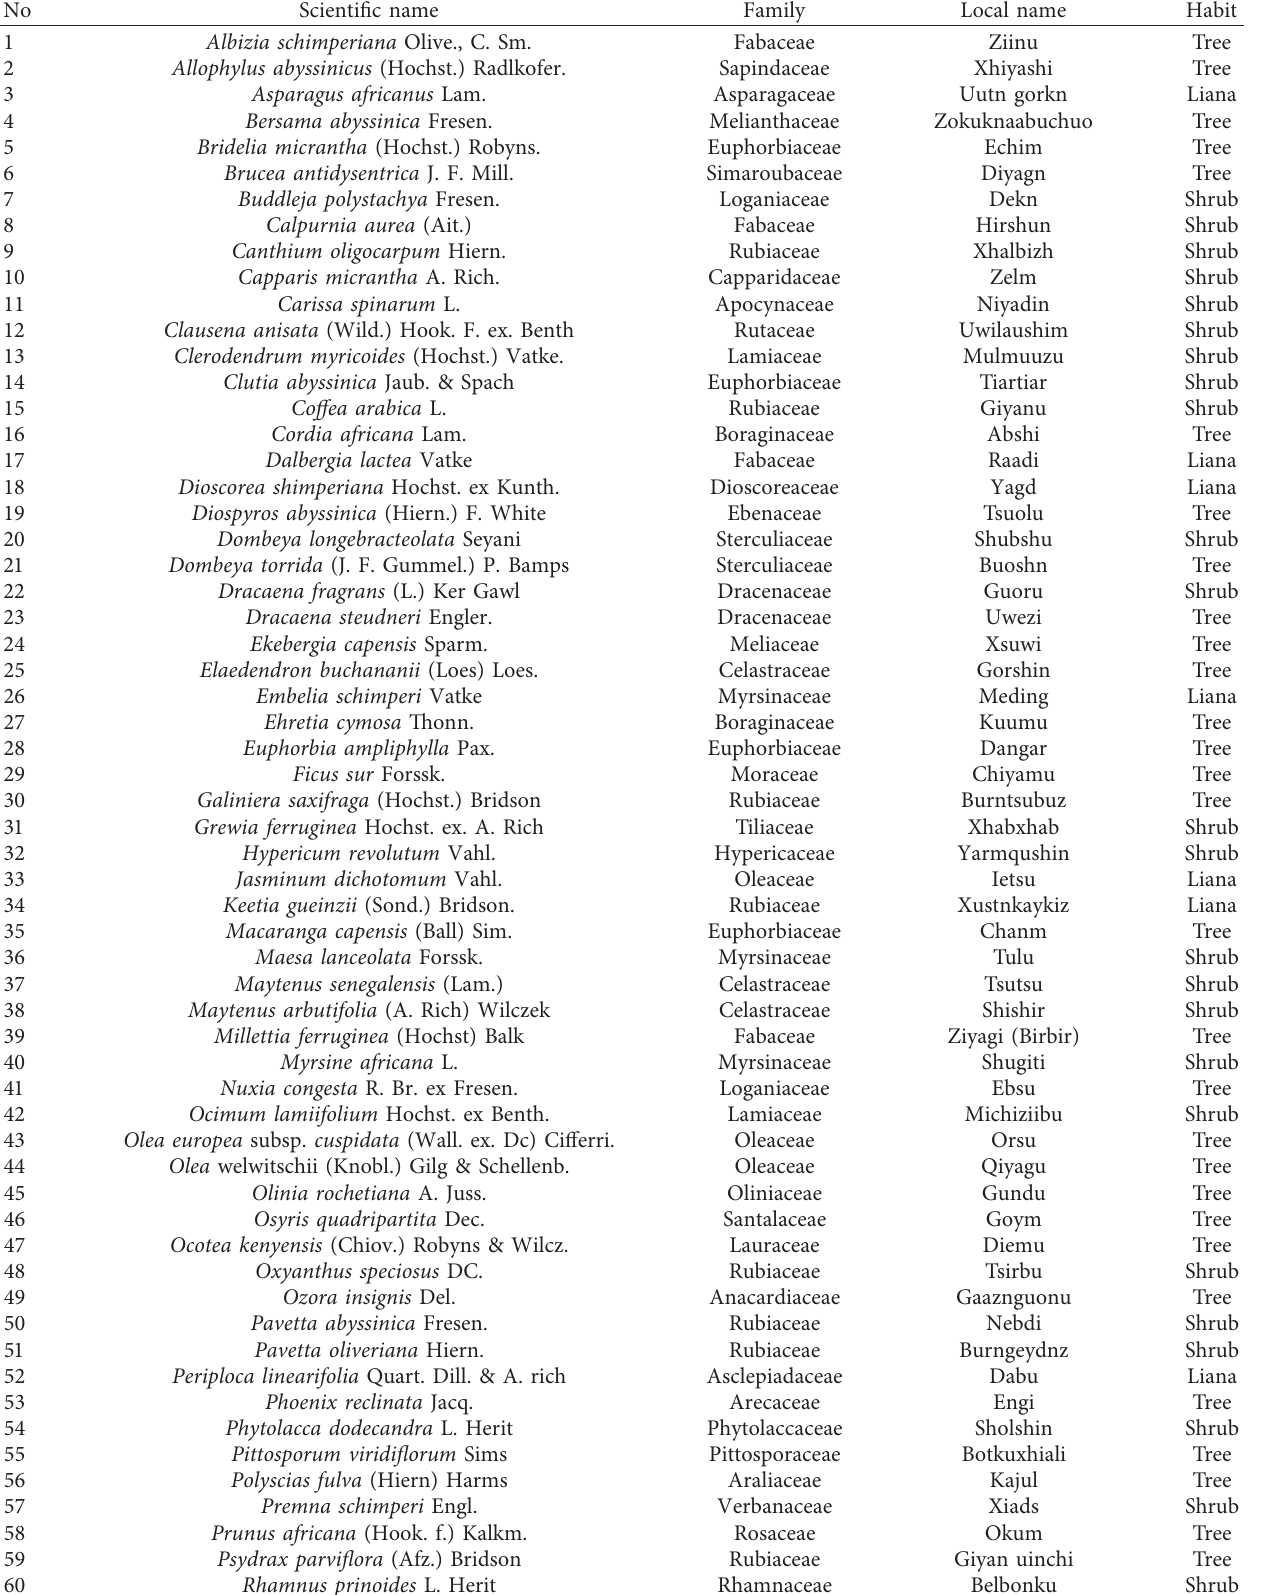
Table 1: List of Woody species collected and identified from Wurg forest, southern